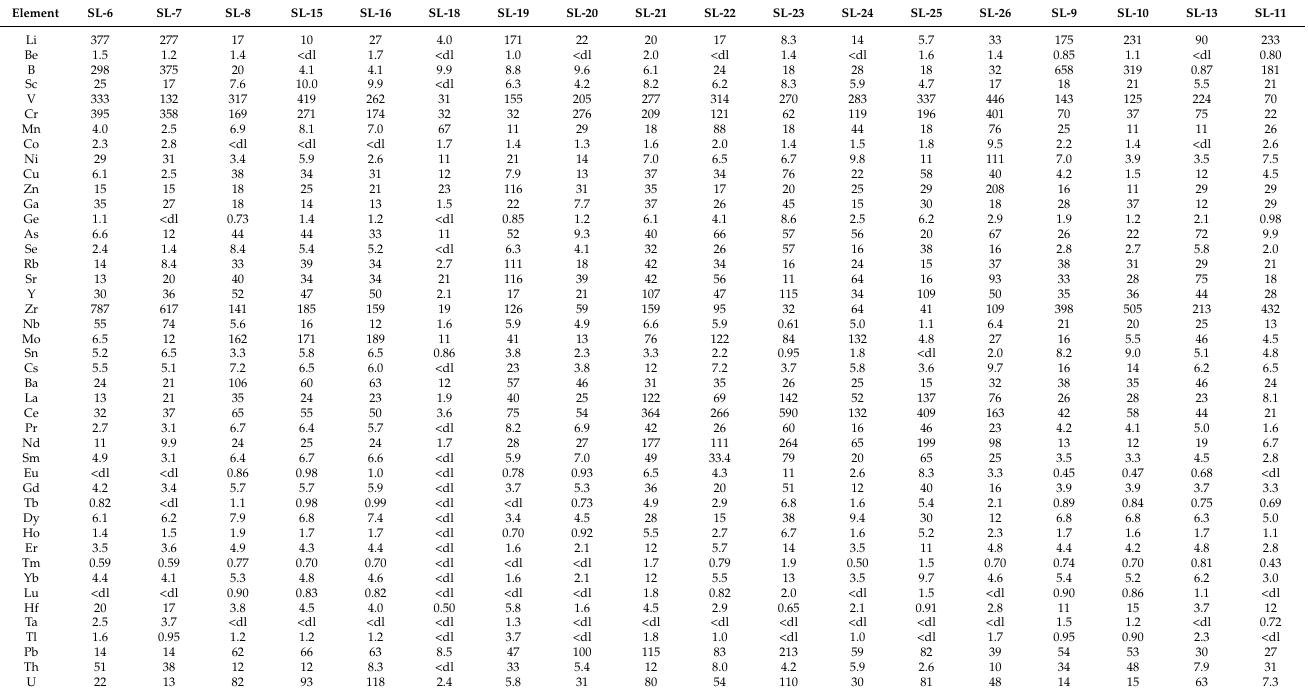
Table 4. Trace element concentrations ( µ g/g) of the coal and non-coal samples from the outcrop profile in the Xian’an Coalfield (on whole-coal basis).